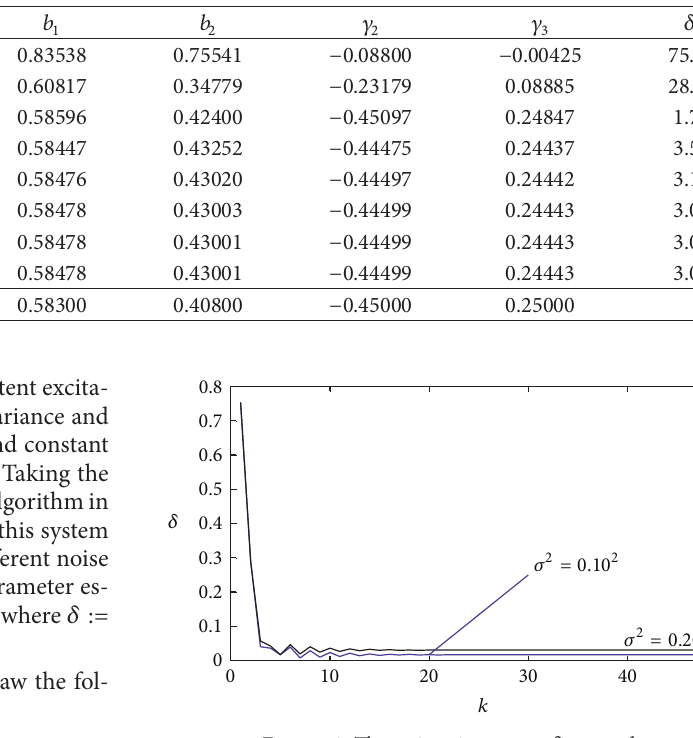
Table 2: The parameter estimates ( 𝑎 𝑖 ,𝑏 𝑖 , 𝛾 𝑖 ) and their errors ( 𝜎 2 = 0.20 2 ).